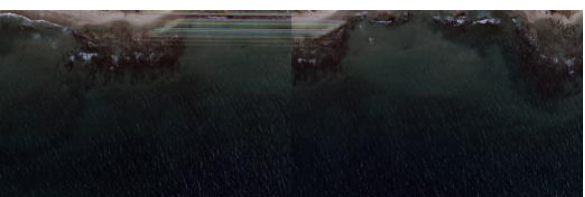
Figure 4c: Matches filtered by RANSAC-fitted homography